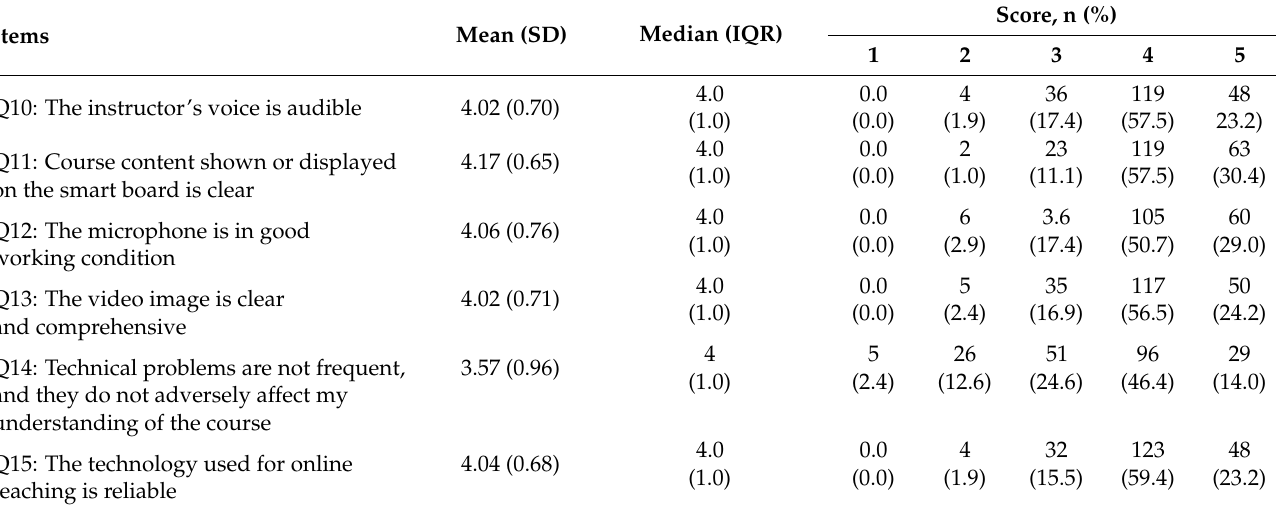
Table 4. Summary of item characteristics for technology (n =